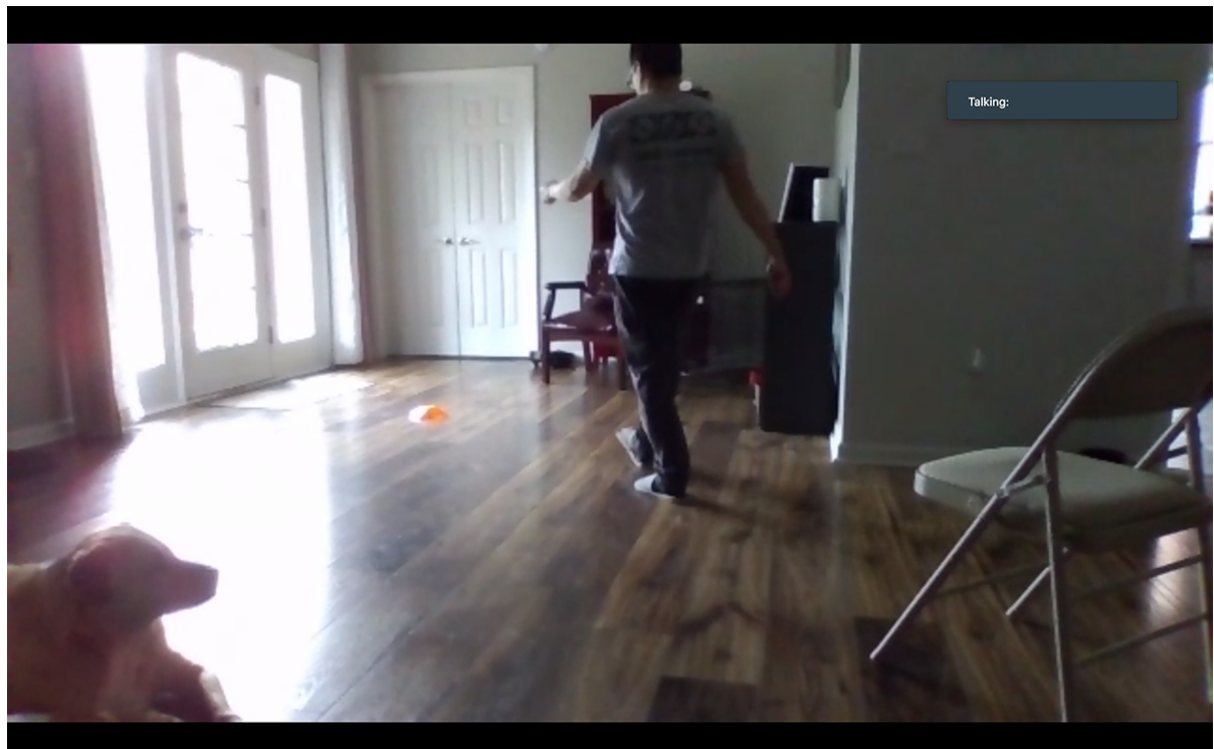
Figure 3. An example of the videoconference view for the Timed Up & Go